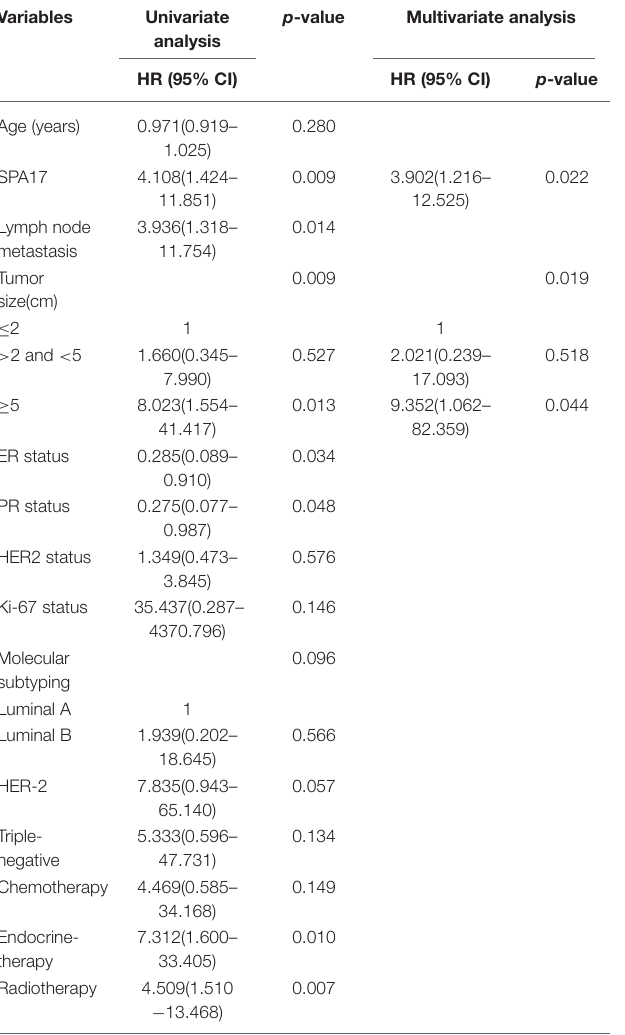
TABLE 3 | Association between clinicopathological features and disease-free survival—Cox regression analysis.